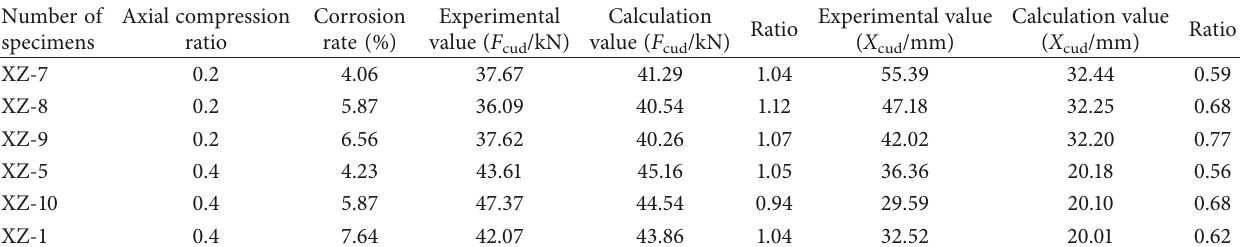
Table 8: The comparison between theoretical value and experimental